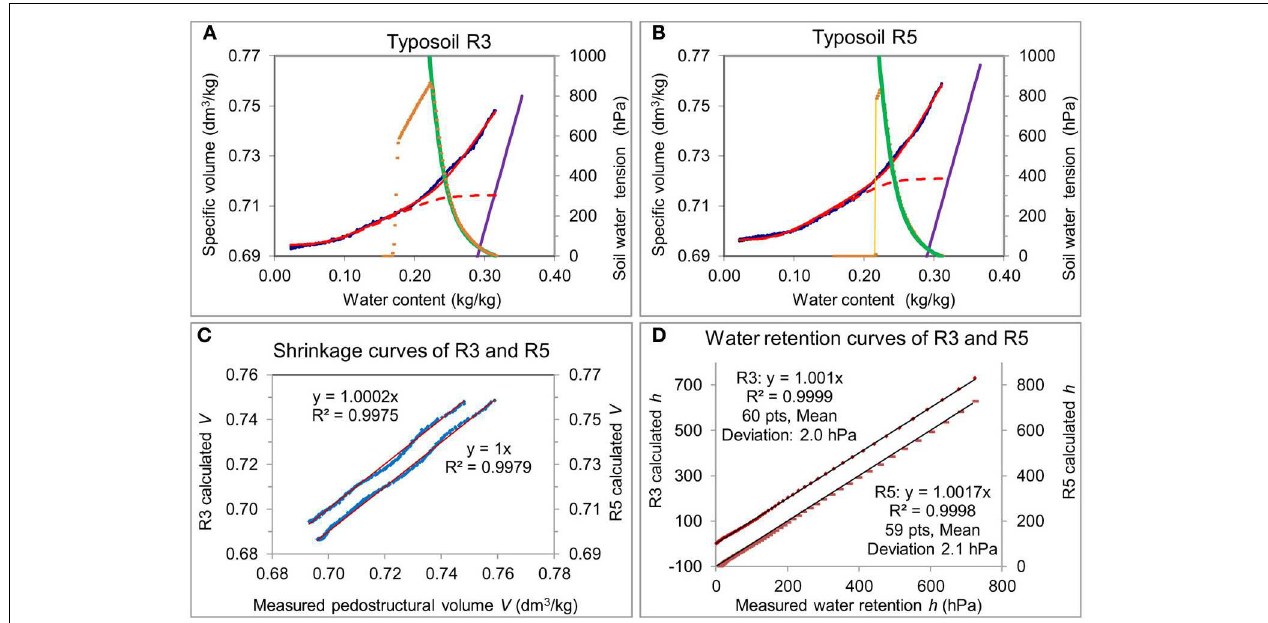
FIGURE 10 | Adjustment of the measured characteristic curves by their theoretical parametric equations for two non-disturbed pedostructure samples of the Rodah soil, R3 and R5. (A,B) represent for each sample the shrinkage curve (ShC), measured (blue points) and calculated (red line) with